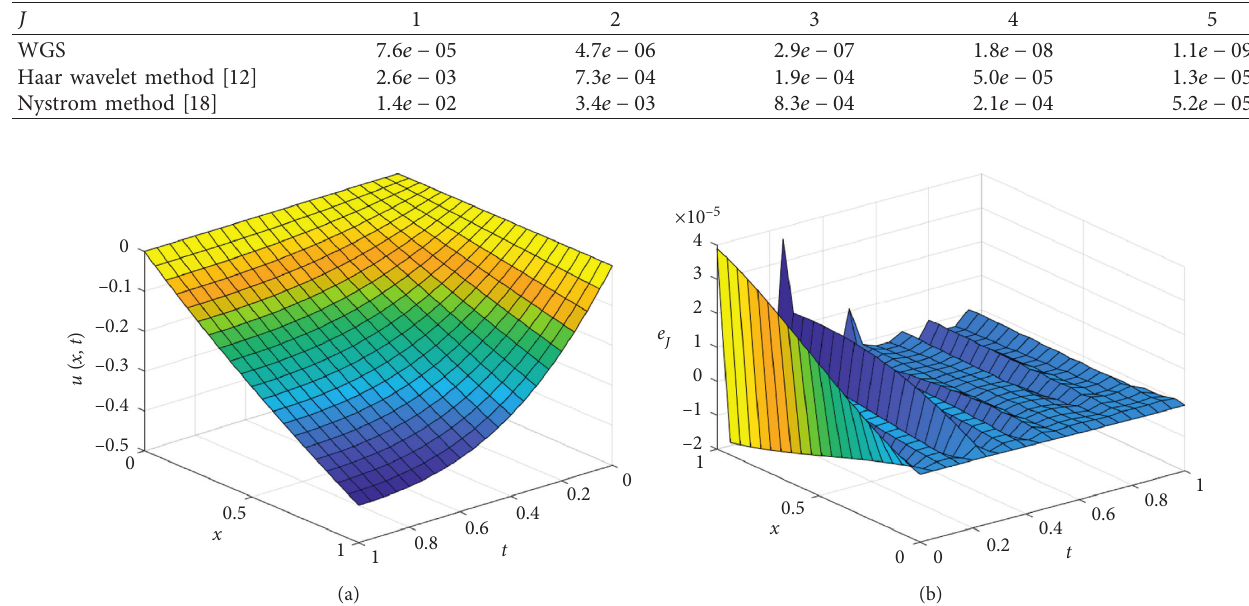
Figure 6: The plots of the approximate solution and the absolute error taking r � 4 and J � 2 for Example